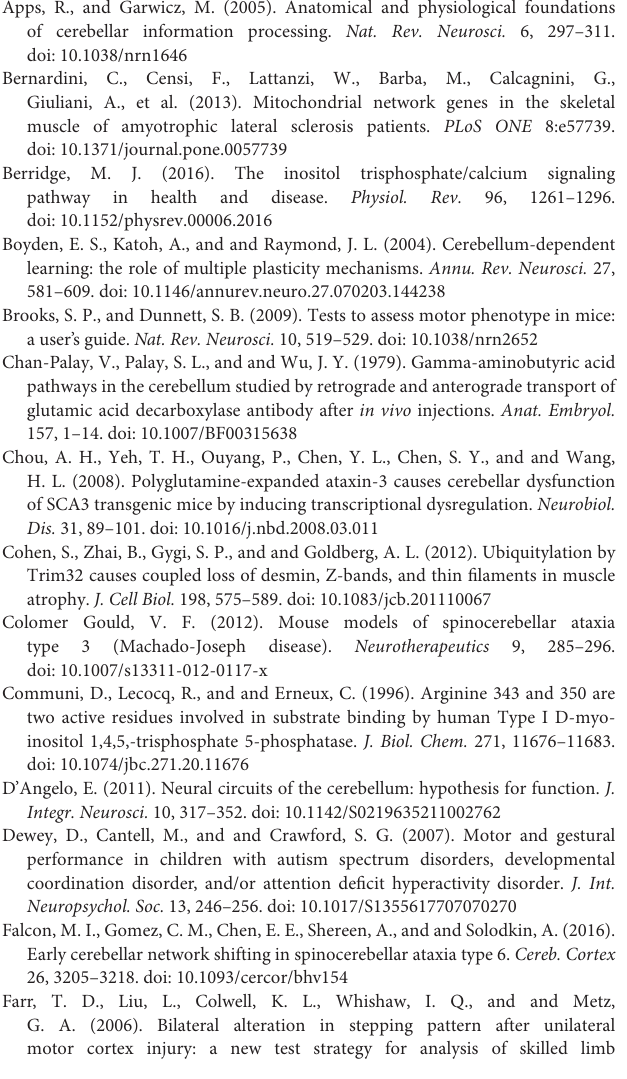
Supplementary Figure 1 | Experimental paradigm of behavioral tests to assess cerebellar motor function. Supplementary Figure 2 | Deficiency of TRIM32 has no effect on granule cells numbers. (A) TRIM32 specific antibody was stained in cerebellar sagittal section in TRIM32 − / – mice. (B) NeuN-positive granule cells in cerebellar GCL in